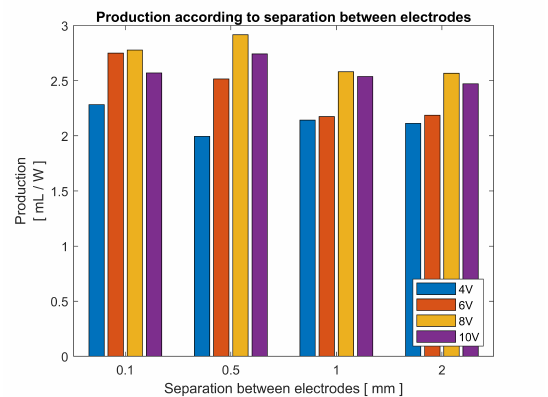
Figure 13. Gas production according to separation between electrodes, with a variation of 4 to 10 V in the power source and pulse frequency of 1